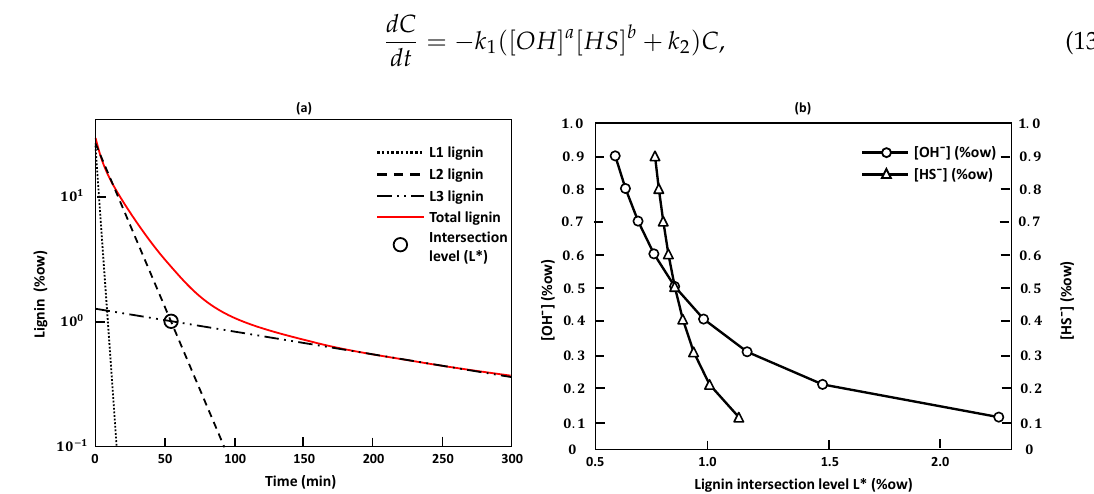
Figure 8. Schematic showing ( a ) L 1, L 2 and L 3 lignin, and ( b ) dependence of the intersection level L ∗ on cooking conditions—in this case [ OH ] and [ HS ]